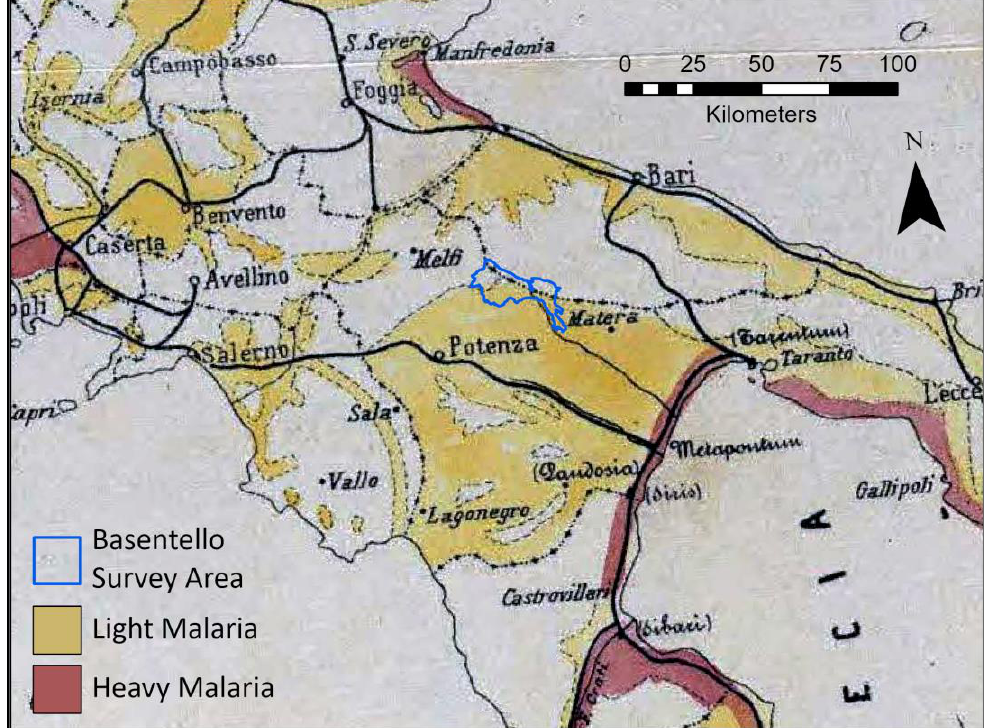
Figure 5. The Basentello Survey Area overlaid on Torelli’s 1882 Carta della Malaria dell’Italia .